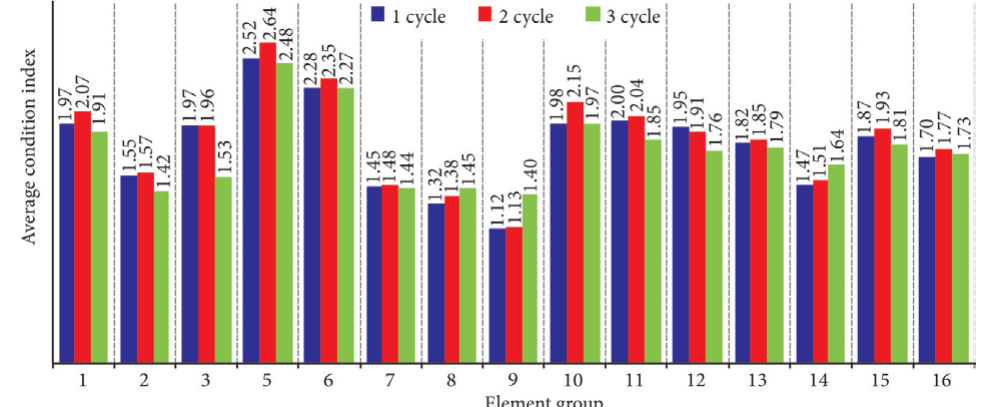
Fig. 1. Average condition indexes of element groups for simply supported beams (Group No.